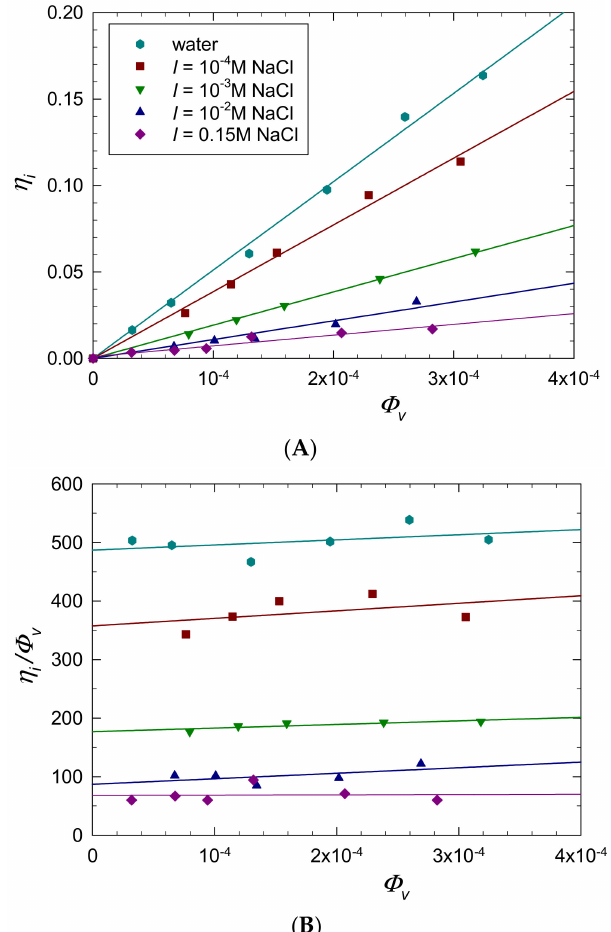
Figure 7. ( A ) Dependence of the relative viscosity η i = η p / η e on the volume concentration of P- Arg solutions Φ V . The solid line denotes a linear fit of experimental data. ( B ) Dependence of η i / Φ V on the volume concentration of P-Arg solutions Φ V . The solid lines denote the linear fits of experimental data.